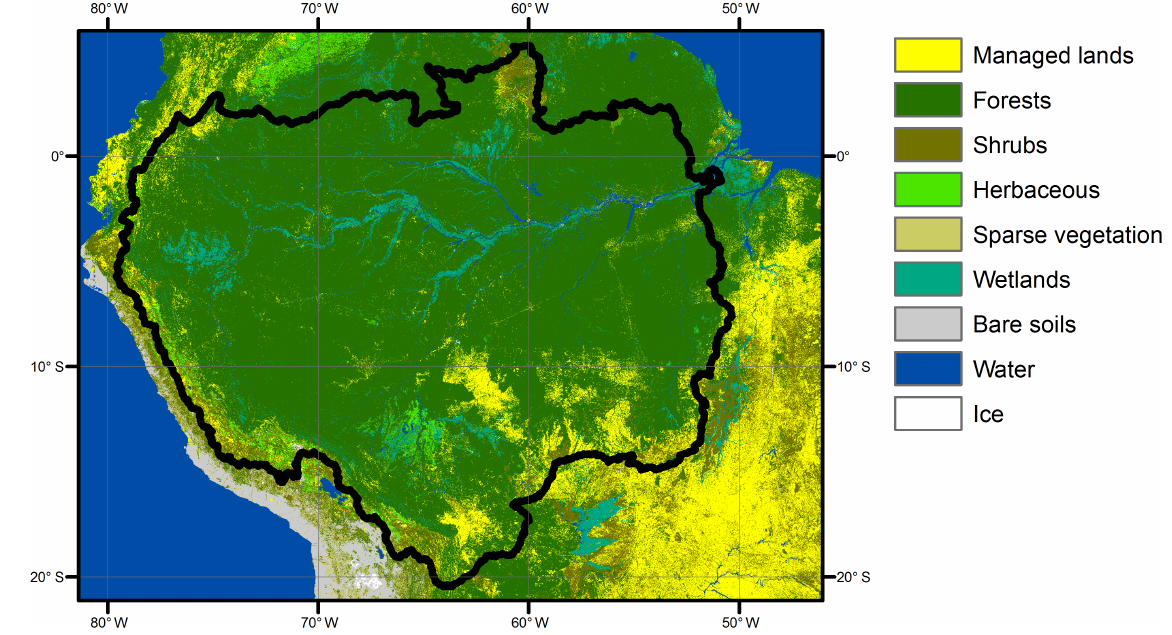
Figure A1. Land cover composition of the study area as representative for the years 2005–2006 derived from GLOBCOVER data (Arino et al., 2008). The black outline represents the Amazon